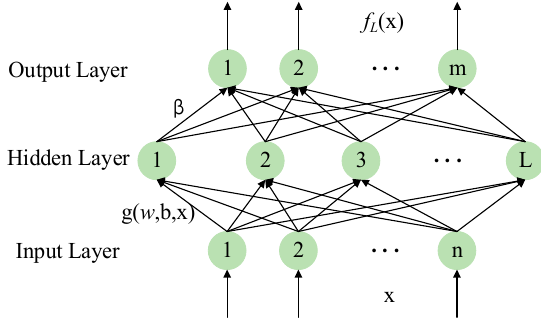
Figure 1. The structure of an extreme learning machine (ELM) network [35].